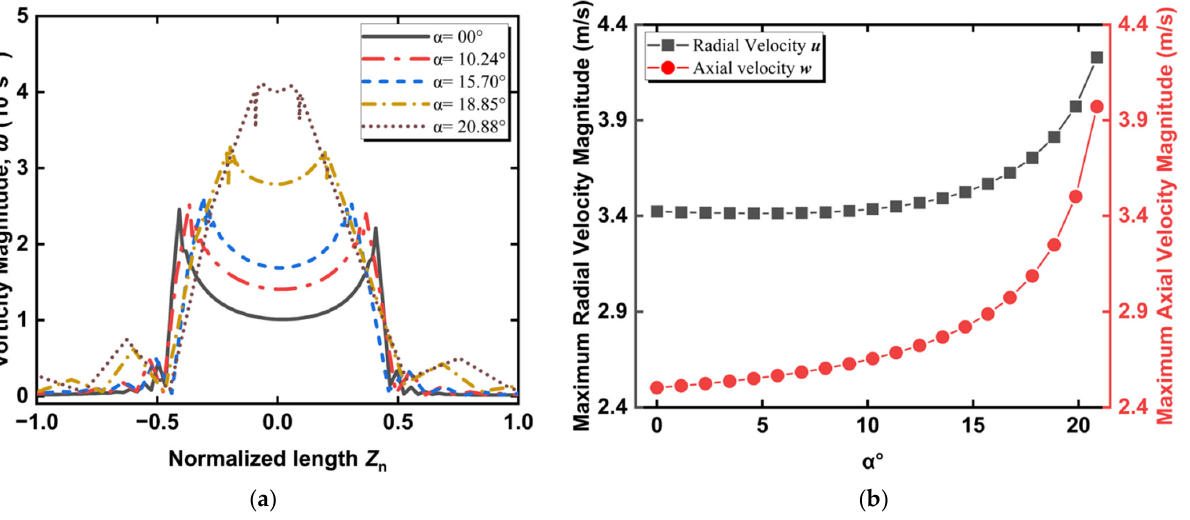
Figure 14. The influence of the offset angle on: ( a ) the vorticity magnitude and ( b ) maximum radial and axial velocity magnitude.